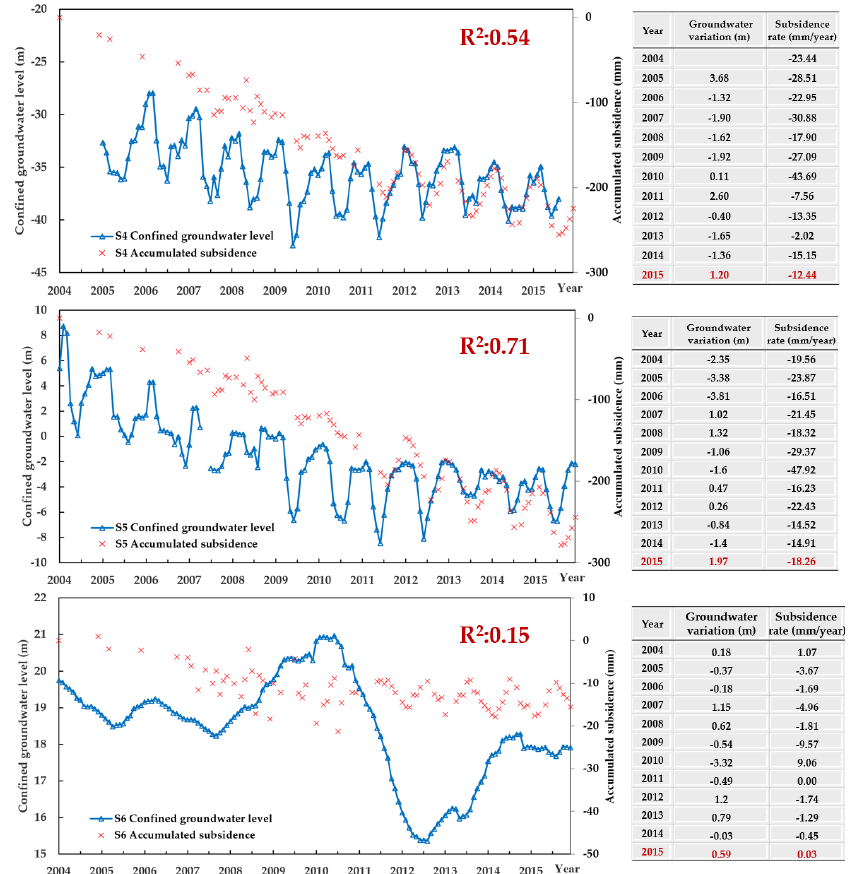
Figure 10. Response relationship between confined water level and land subsidence from 2004 to 2015 (subsidence mutation occurred in 2015).